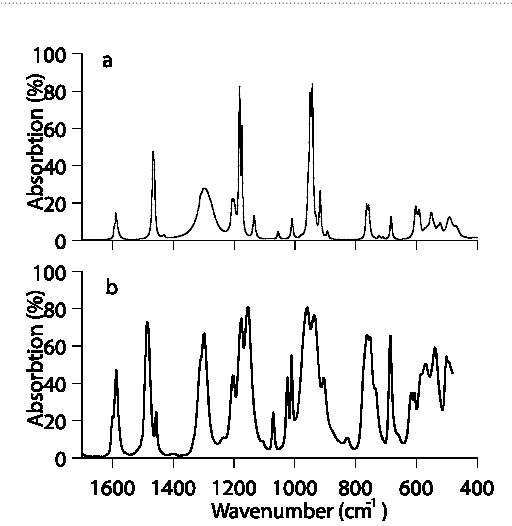
Figure 9. Calculated (a) and experimental (b) IR spectra of diphenyl chlorophosphate. Theoretical IR spectrum of mixture was obtained for x(-sc/+sc)=40%, x(ap/+sc,- sc/ap)=45%, x(+sc/+sc,-sc/-sc)=15% and x(+sc/ ap,ap/-sc)=